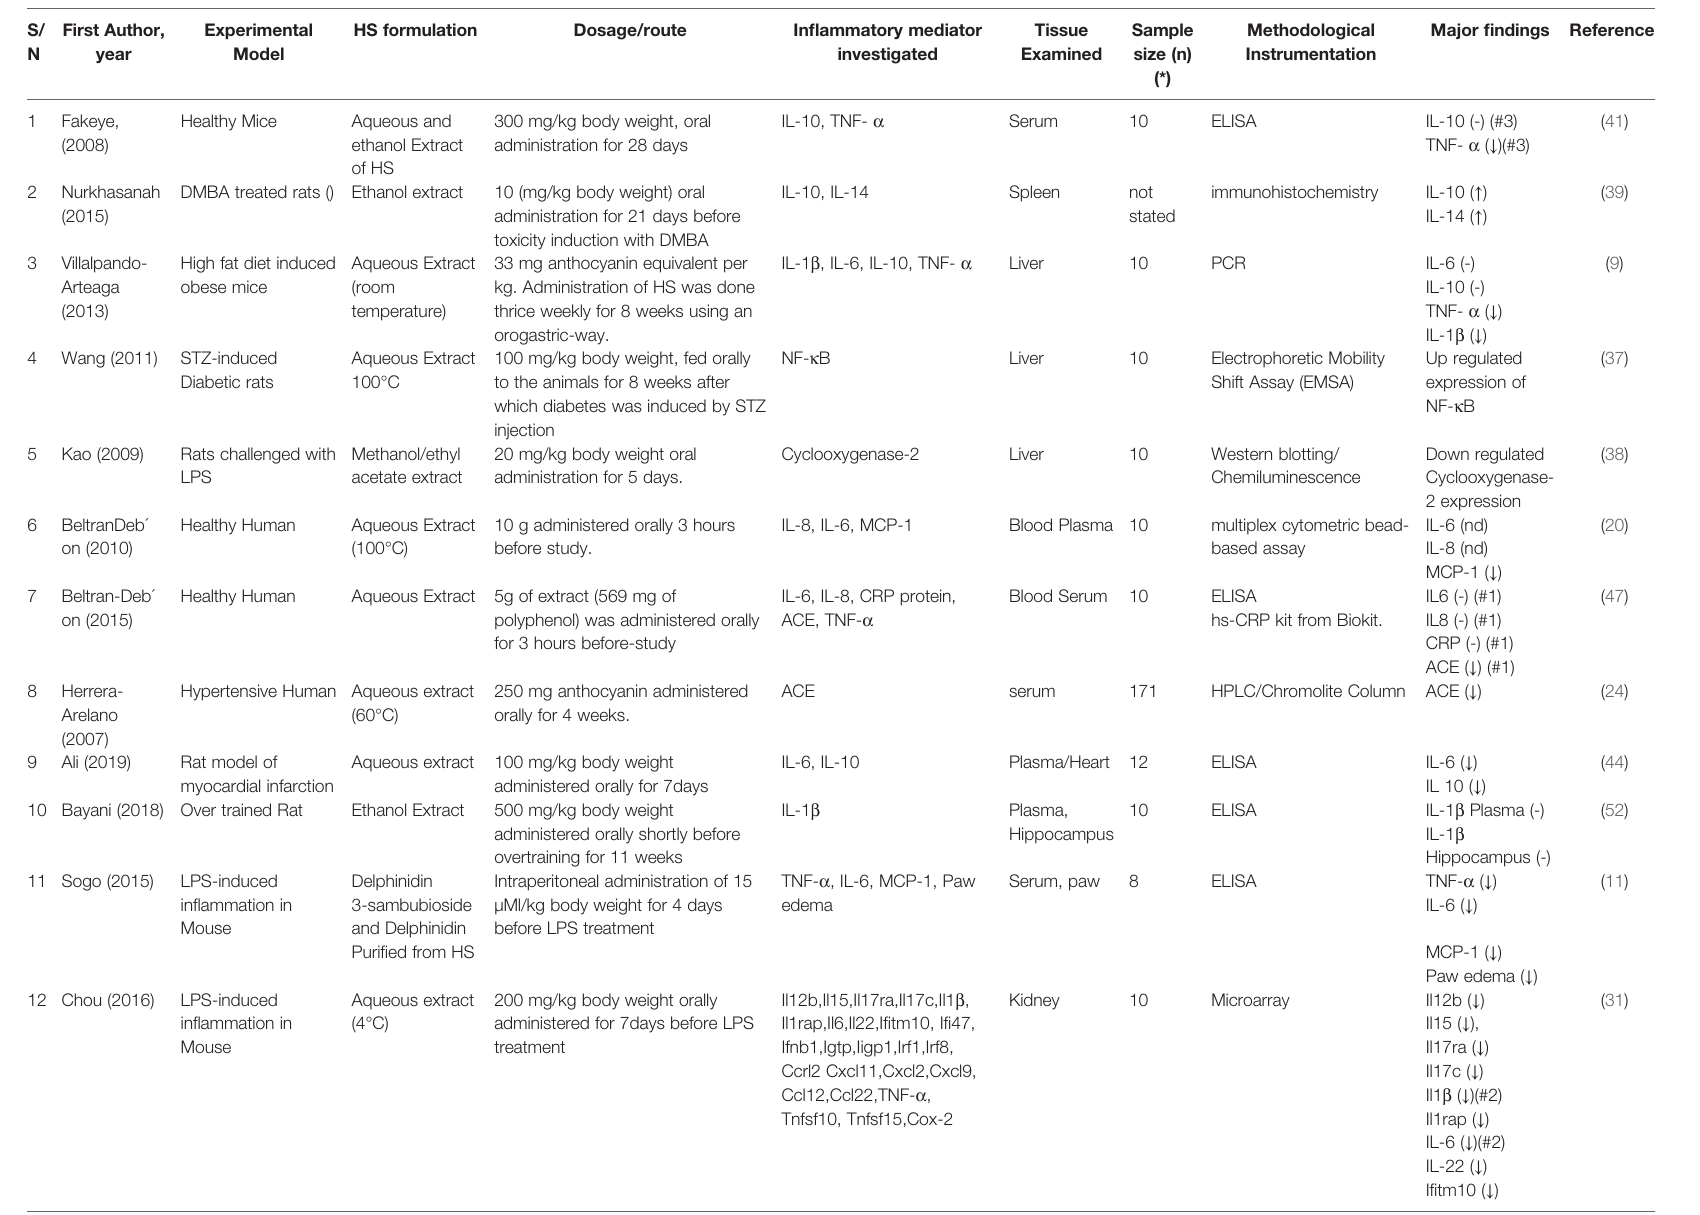
TABLE 2 | HS effects on in fl ammation biomarkers in included